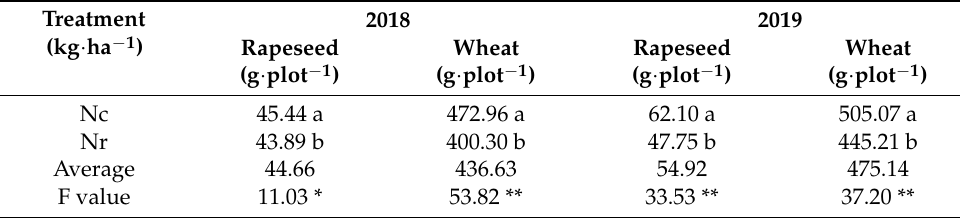
Table 3. Effects of N application rate on yield of rapeseed and wheat over two years.